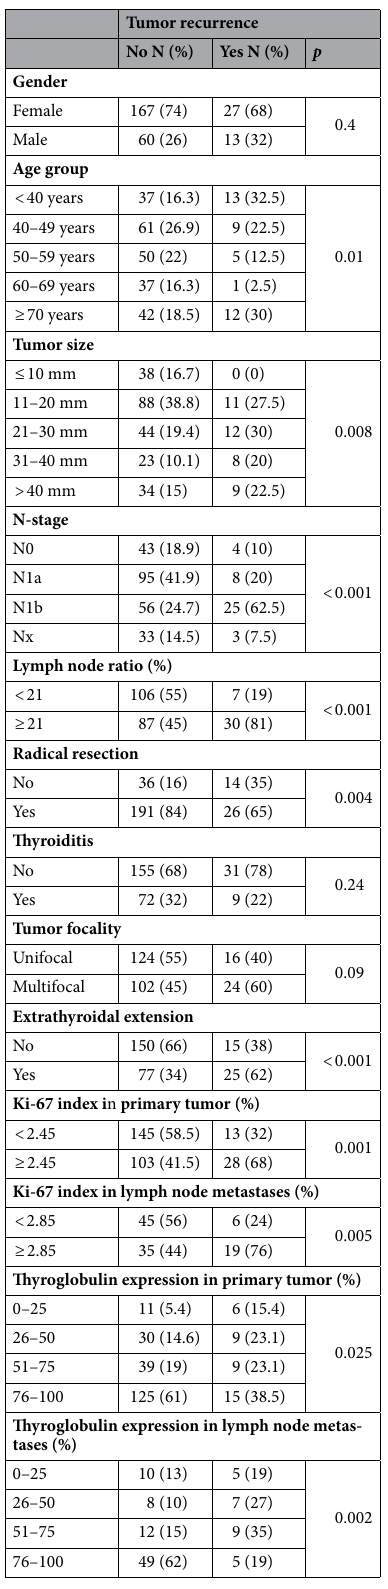
Table 3. Univariate analysis comparing tumor recurrence in relation to clinicopathological data of papillary thyroid cancer